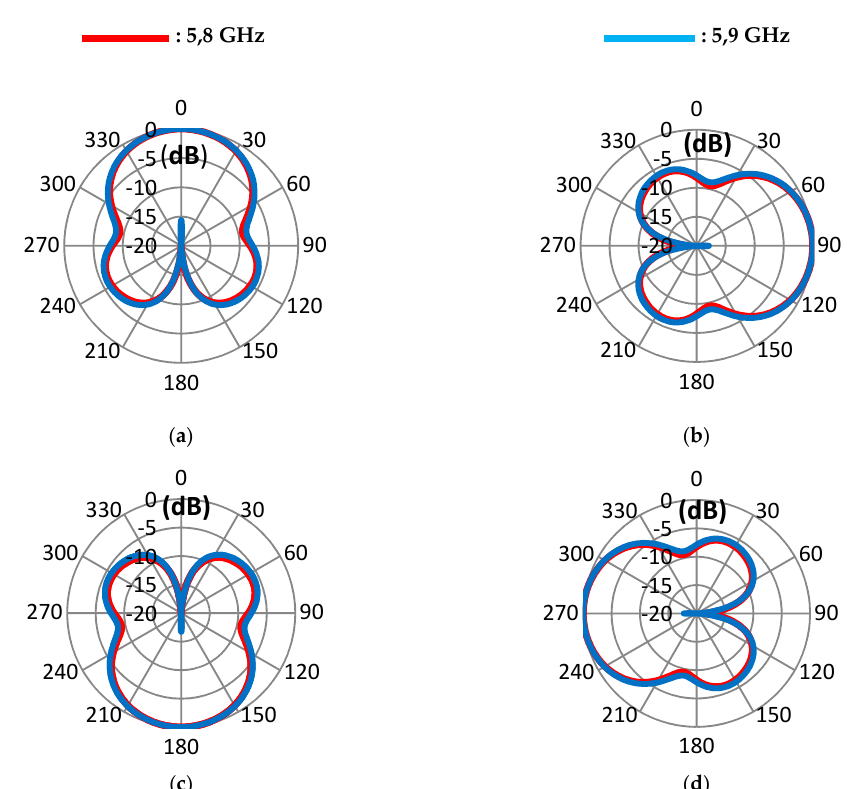
Figure 8. Simulated radiation patterns of the proposed wideband reconfigurable antenna in azimuth Plane: ( a ) State 1, ( b ) State 2, ( c ) State 3, ( d ) State 4.